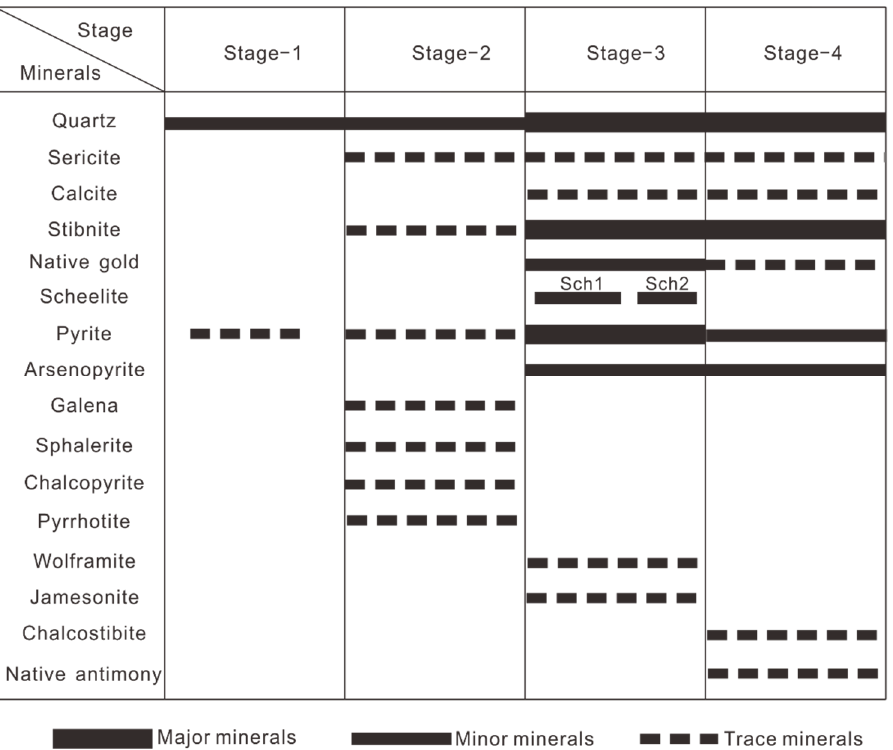
Figure 5. Paragenesis of the mineral assemblages showing the mineralized sequence of the Longshan Sb-Au deposit, South China. Line thickness indicates approximate relative mineral abundance.